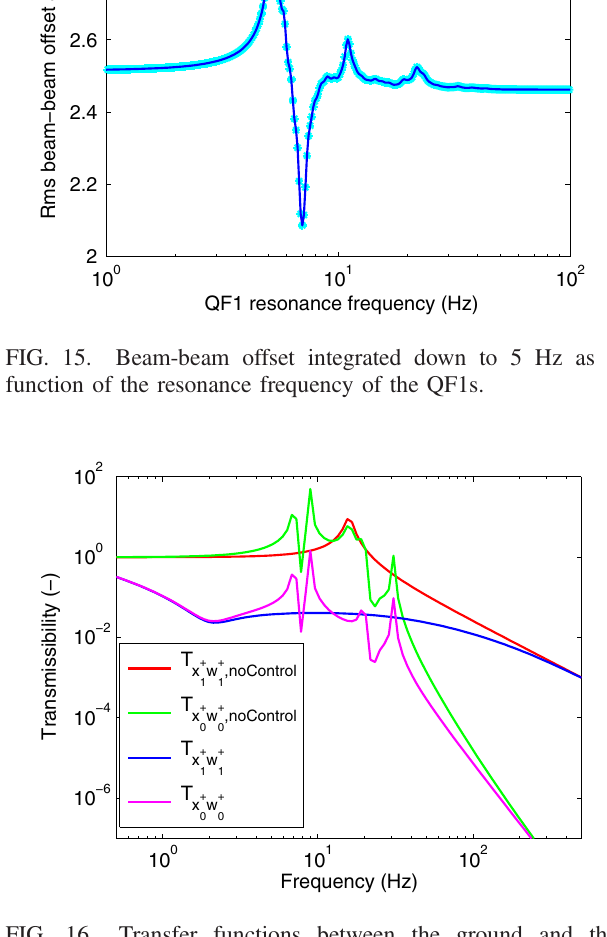
FIG. 16. Transfer functions between the ground and the quadrupoles, with and without control.